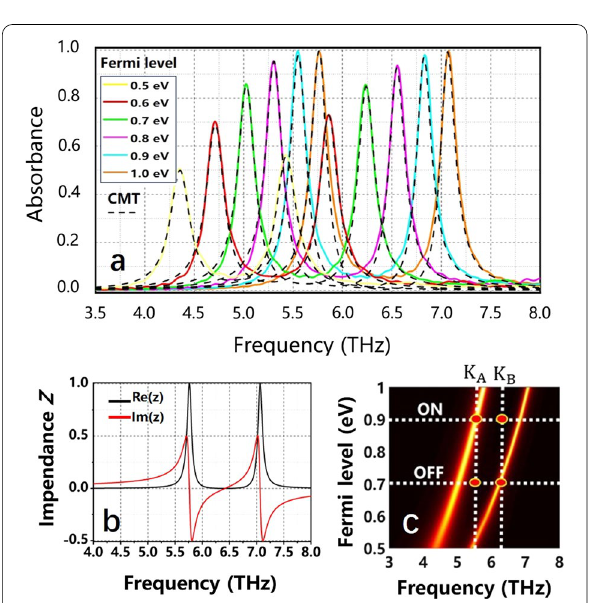
Fig. 4 a The spectra of the FDTD numerical and CMT simulation with the Fermi level changing from 0.5 to 1.0 eV. b The real and imaginary parts of the impedance Z when E f diagram of absorption with the Fermi level and frequency. Here, the discussed structure is Fig. 1a and other parameters are n d